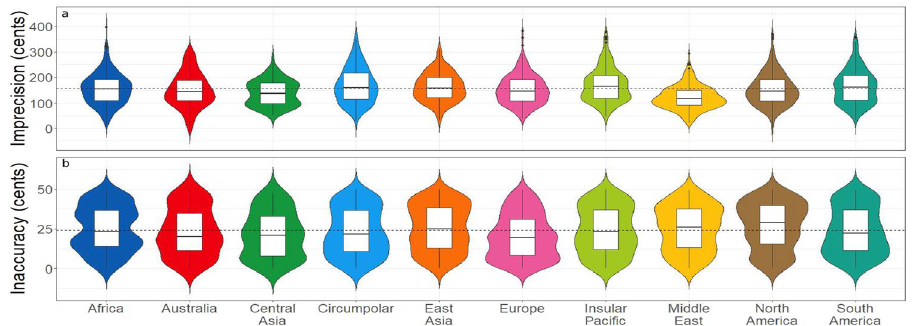
Figure 3. Global vocal pitch-class imprecision and inaccuracy. ( a ) The distributions of pitch-class range across regions as a measure of pitch-class imprecision, shown as violin plots. ( b ) The distributions of pitch-class accuracy across regions, shown as violin plots. The violin plots are color-coded for musical style-region as per Fig. 1. The outer colored plot presents a mirrored kernel density estimation, meaning that the shape on either side of the box plot is a smoothed histogram of the data. The inner box plot presents the median as a horizontal line, the interquartile range (IQR; 25th and 75th percentiles) as a box, and whiskers that extend to the maximum and minimum values (excluding outlying points, which are plotted individually. Outlying points are those that are further than 1.5 times the IQR from either the 25 th or 75 th percentile.) The global mean for each variable is represented by a dashed